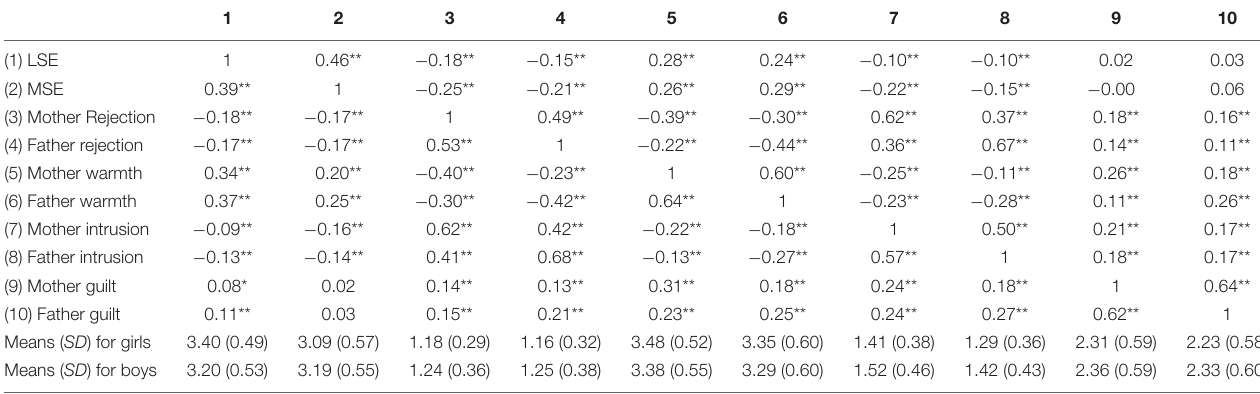
TABLE 1 | Intercorrelations between the study variables and means and standard deviations (SD).